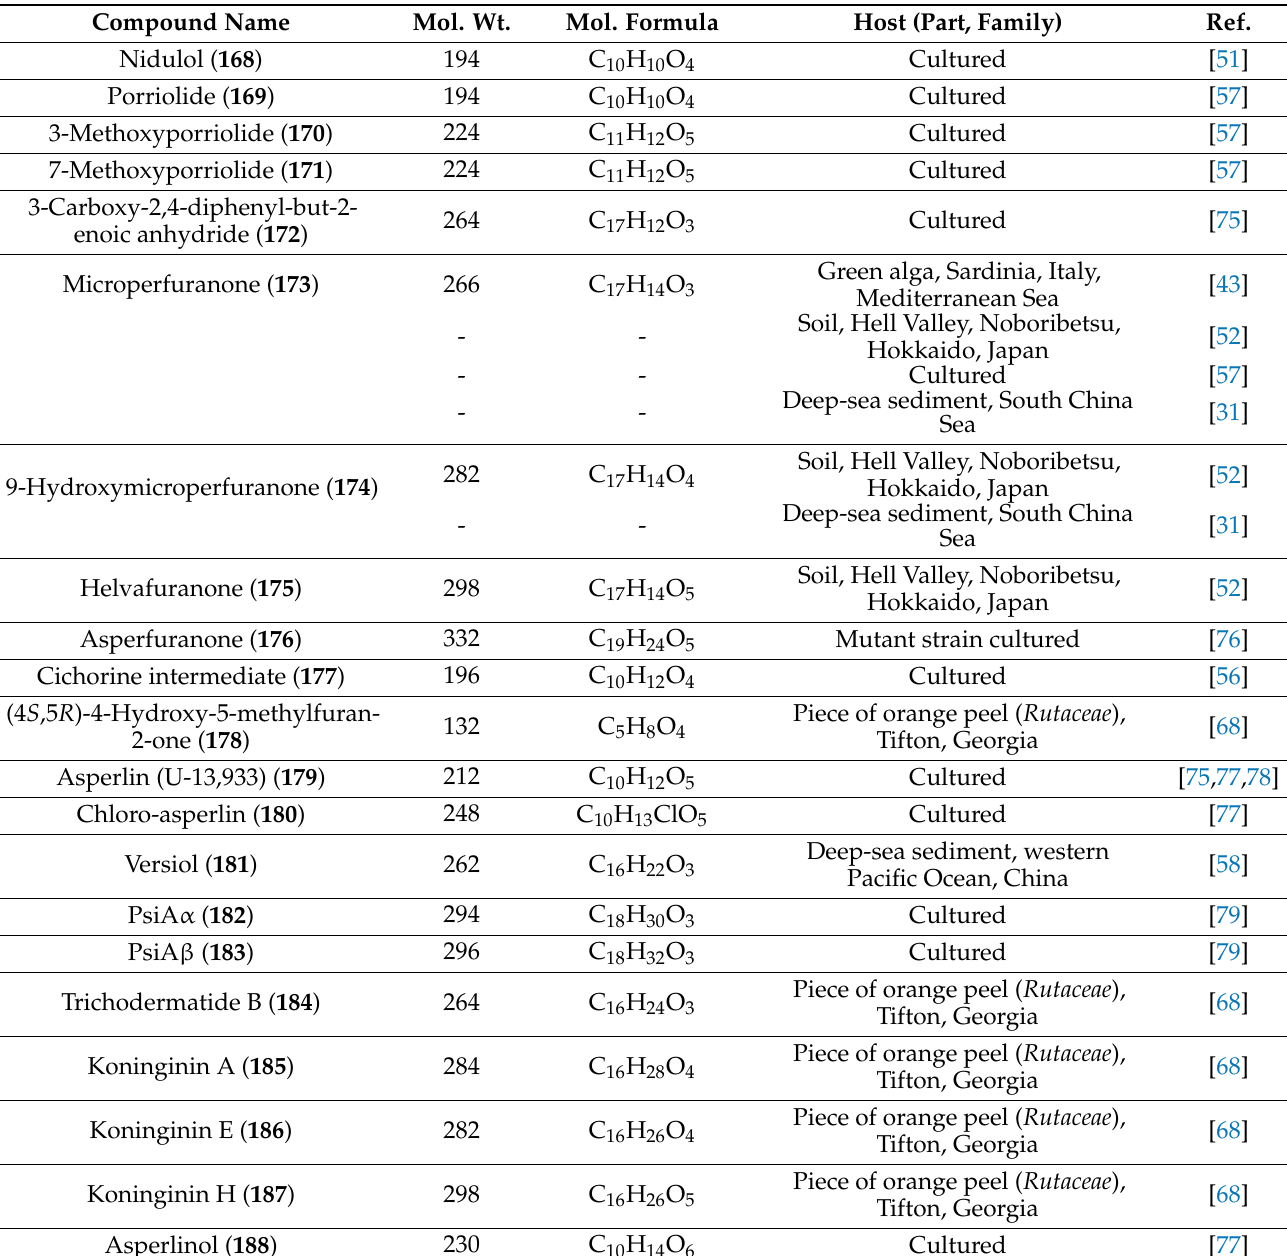
Table 12. Furan and pyran derivatives reported from A. nidulans